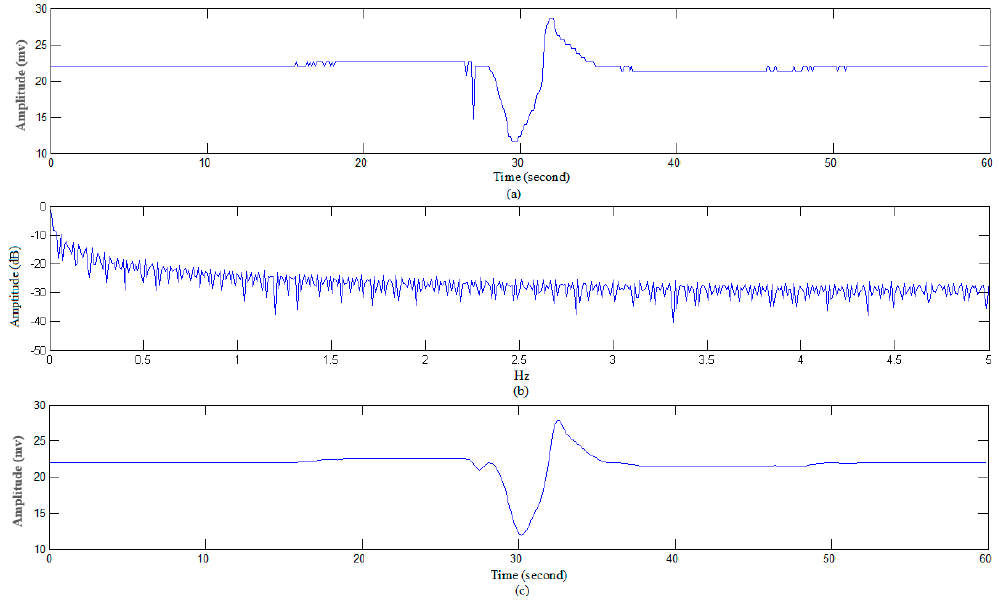
Figure 6. AP of cucumber ( a ) Raw signal; ( b ) Frequency spectrum of raw signal; ( c ) Frequency spectrum of raw signals in log scale; ( d ) Signal after filtering.